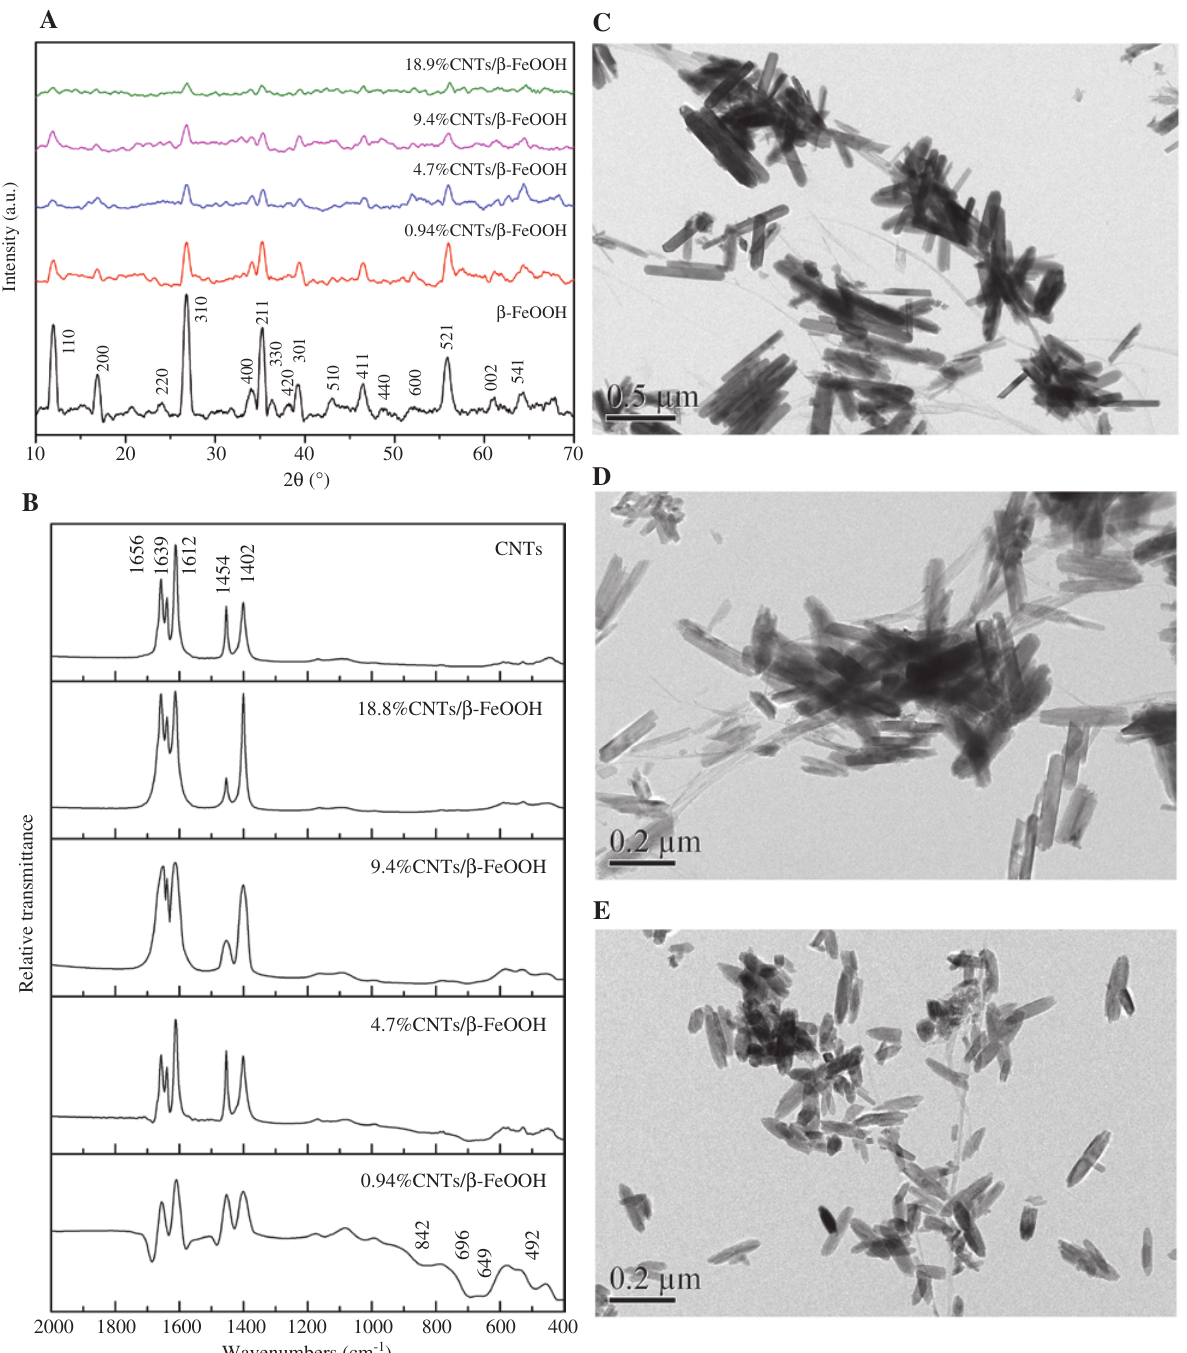
Figure 1: XRD patterns of the as-prepared β -FeOOH and CNT/ β -FeOOH composites (A); characteristic parts of the FTIR spectra of CNTs and CNTs/ β -FeOOH composites (B); TEM images of 0.94%CNTs/ β -FeOOH (C); 4.7%CNTs/ β -FeOOH (D); 9.4%CNTs/ β -FeOOH (E); 18.8%CNTs/ β -FeOOH (F); UV-vis DRS of β -FeOOH and CNTs/ β -FeOOH composites